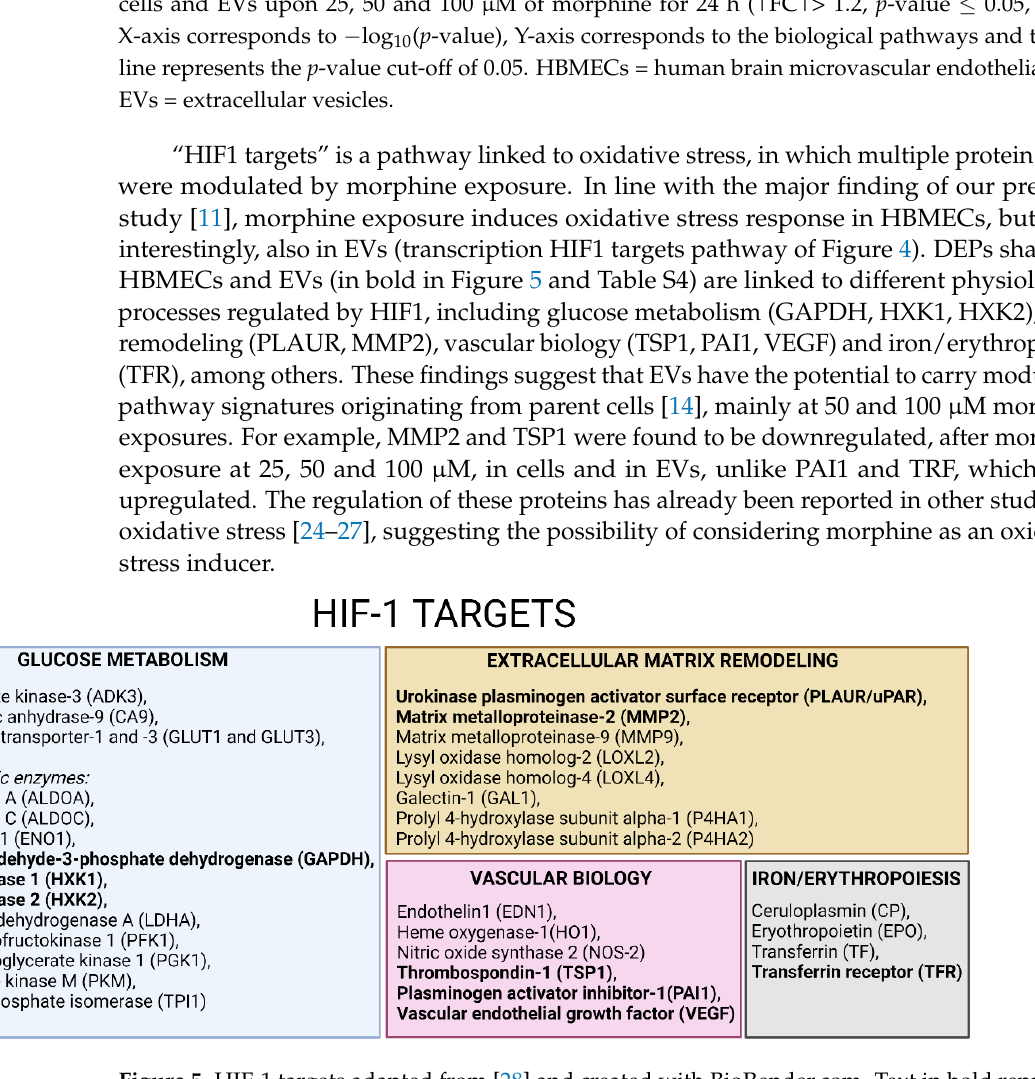
Figure 5. HIF-1 targets adapted from [28] and created with BioRender.com. Text in bold represents DEPs found in HBMECs and EVs upon various morphine concentrations.